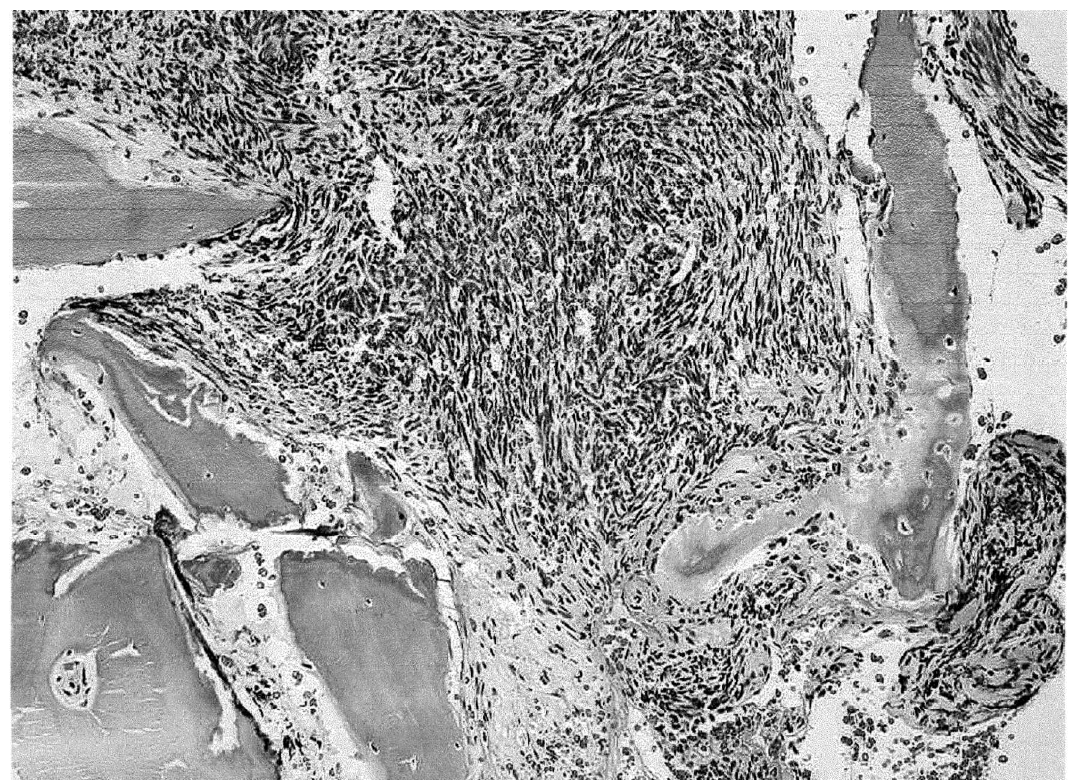
Fig. 1. Photomicrograph of the schwannoma (centre) invading bone that can be seen on both sides of the lesion. Correspondence to: P. Ramasamy, 15 Paddock Close, Branson Court, Bradley Stoke North, Bristol BS32 0EX,UK.Tel.+44 1925 662382; Fax. +44 1925 662211; E-mail: